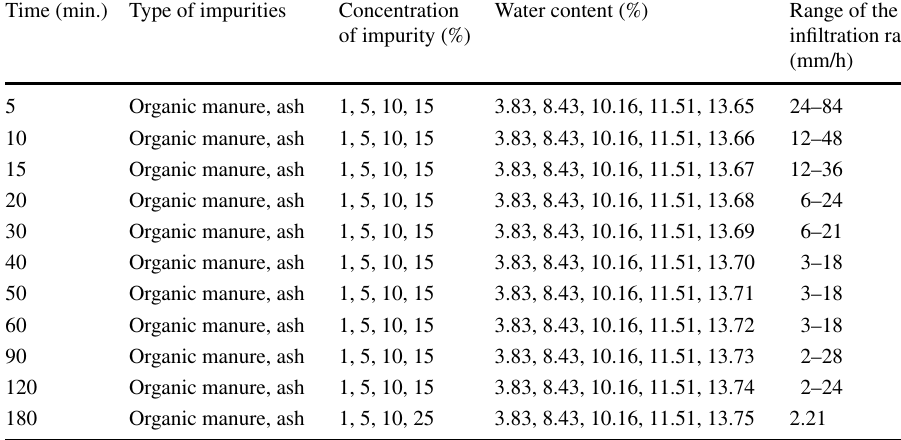
infiltration rate